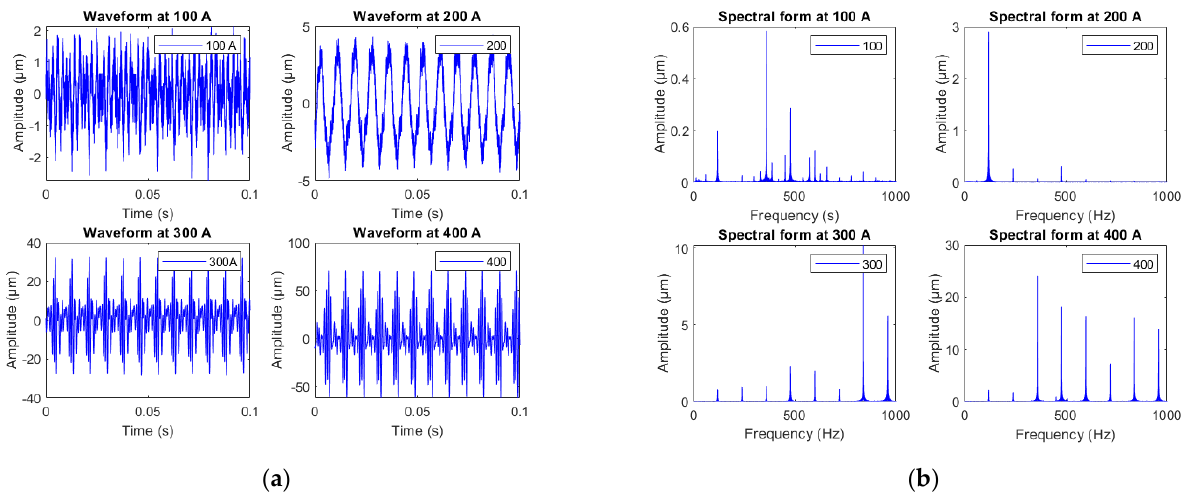
Figure 12. Influence of the loading current on the winding vibrations. ( a ): temporal waveforms of the vibration, ( b ): spectral forms of the vibrations.